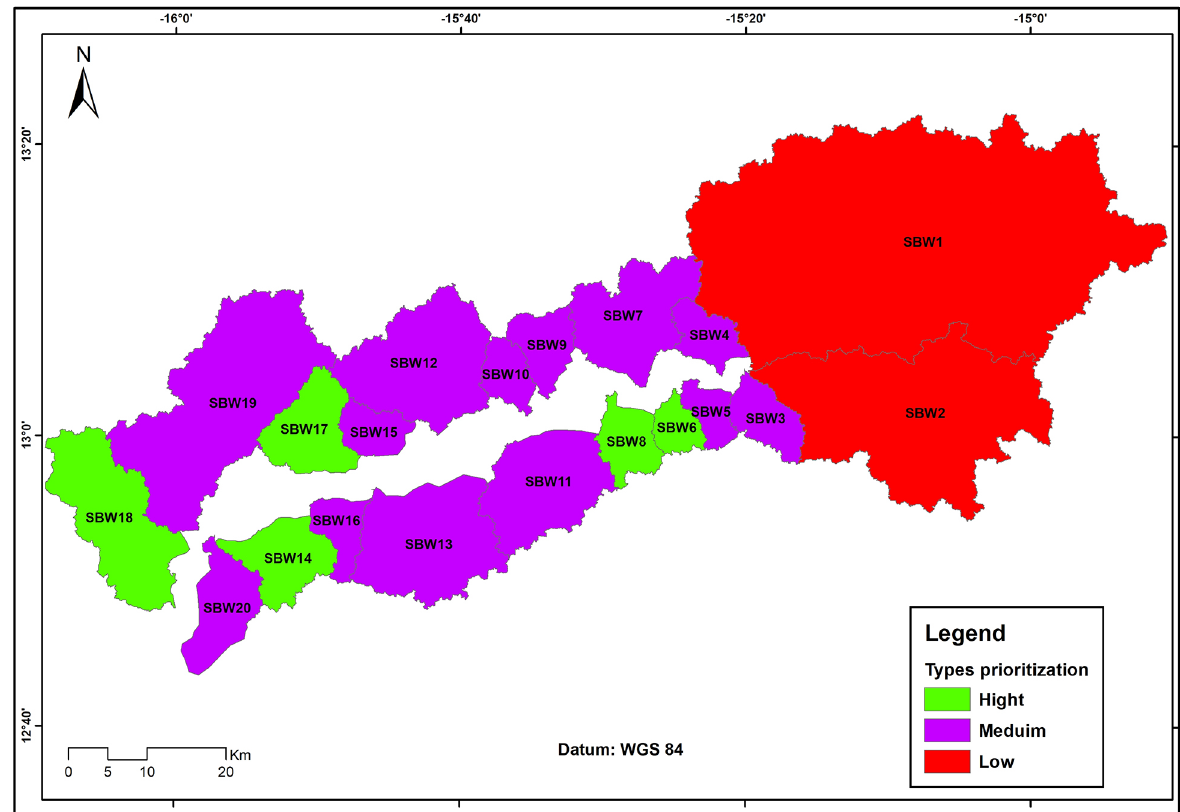
Fig. 6. Prioritisation based on morphometric analysis of the Soungrougrou